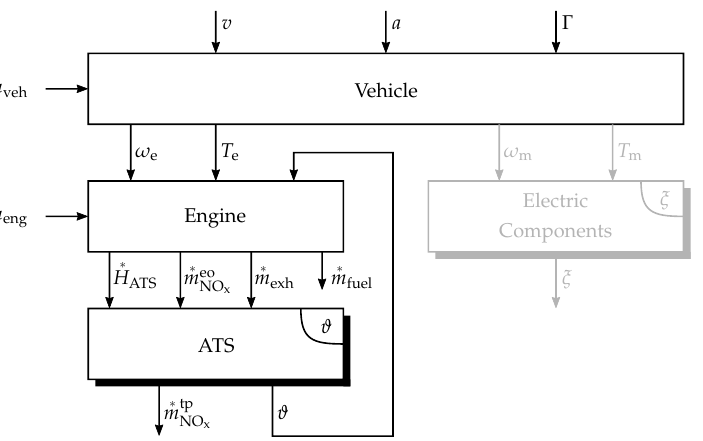
Figure 8. Signal flows within the powertrain model. The blocks featured only in the HEV are shown in